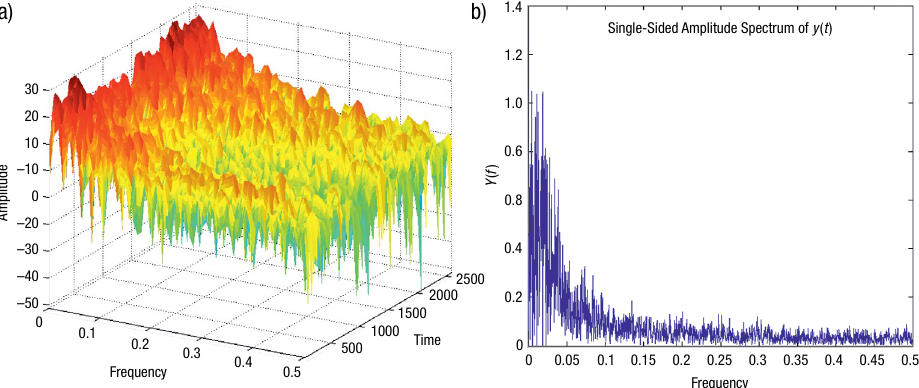
Fig. 14. The Boeing Company (BA) – 1 day price series, spectrogram (a), spectrum (b)